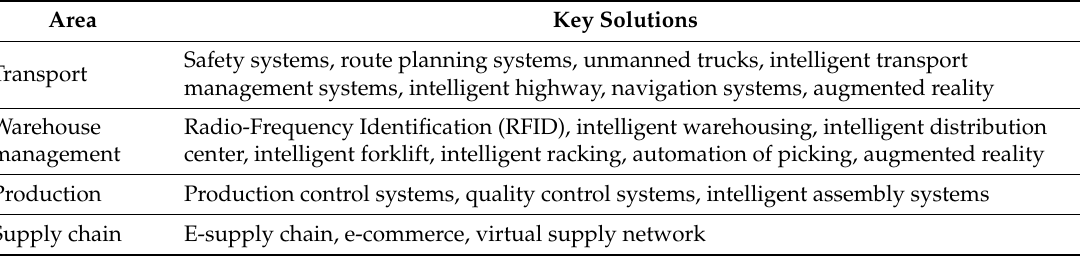
Table 1. Selected solutions, resulting from the implementation of digital technology in the area of logistics.